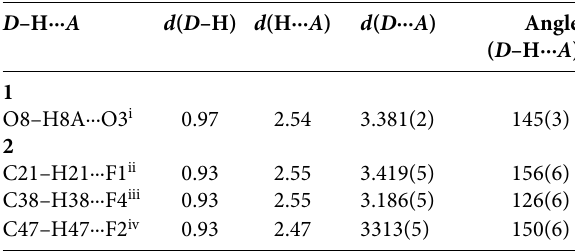
Table 3. Hydrogen bond distances (Å) and bond angles (º) for the complexes